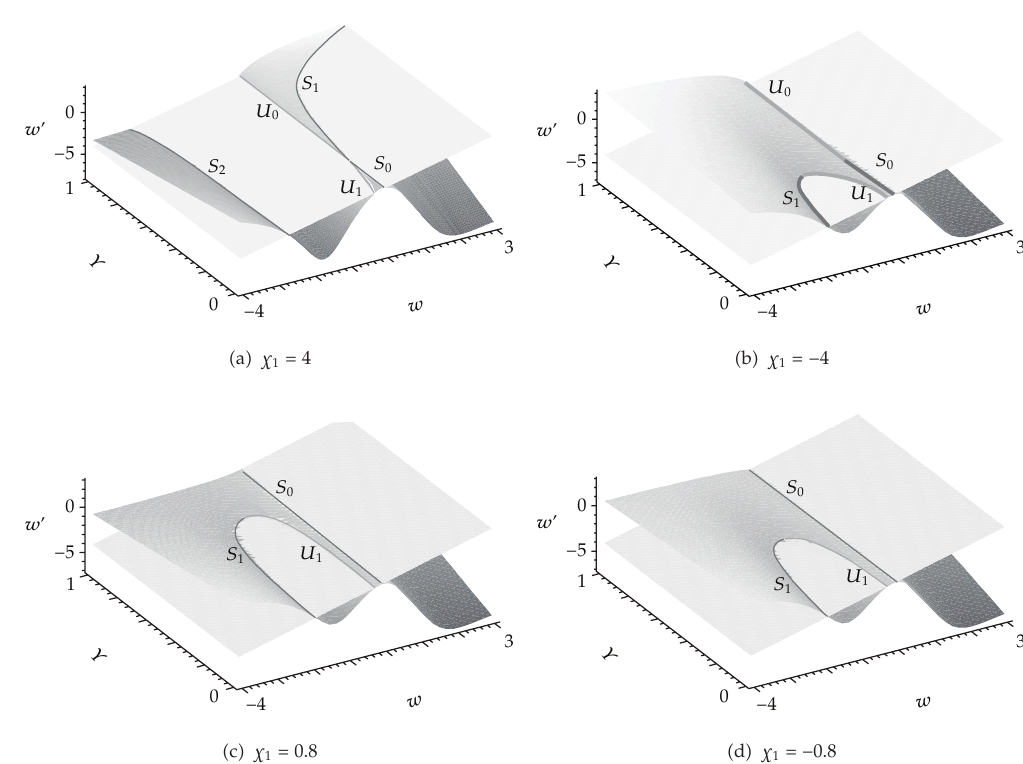
Figure 11: Di ff erent behaviours of agents for χ 2 (cid:7) 15 and many values of χ 1